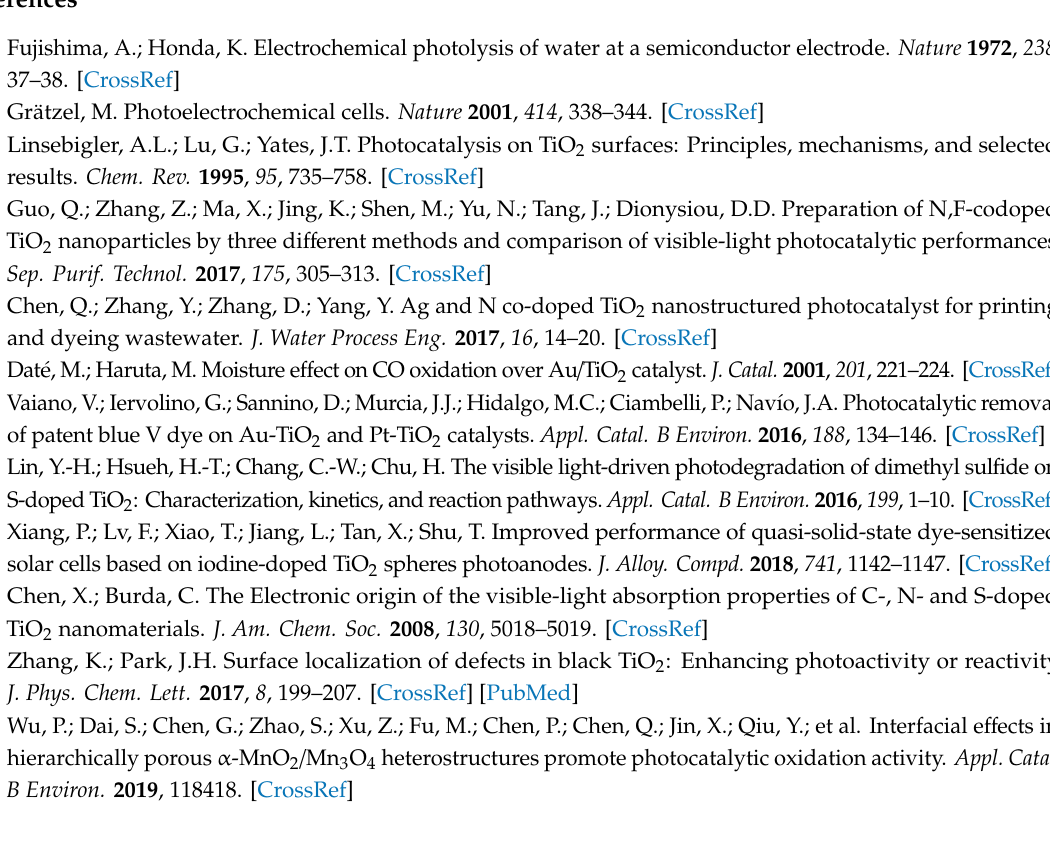
Figure S1: (A) The selected area for elements analysis in TEM of Ti420, and (B) the EDS resulte, Table S1: The integrated peak area of the di ff raction peak at (101)